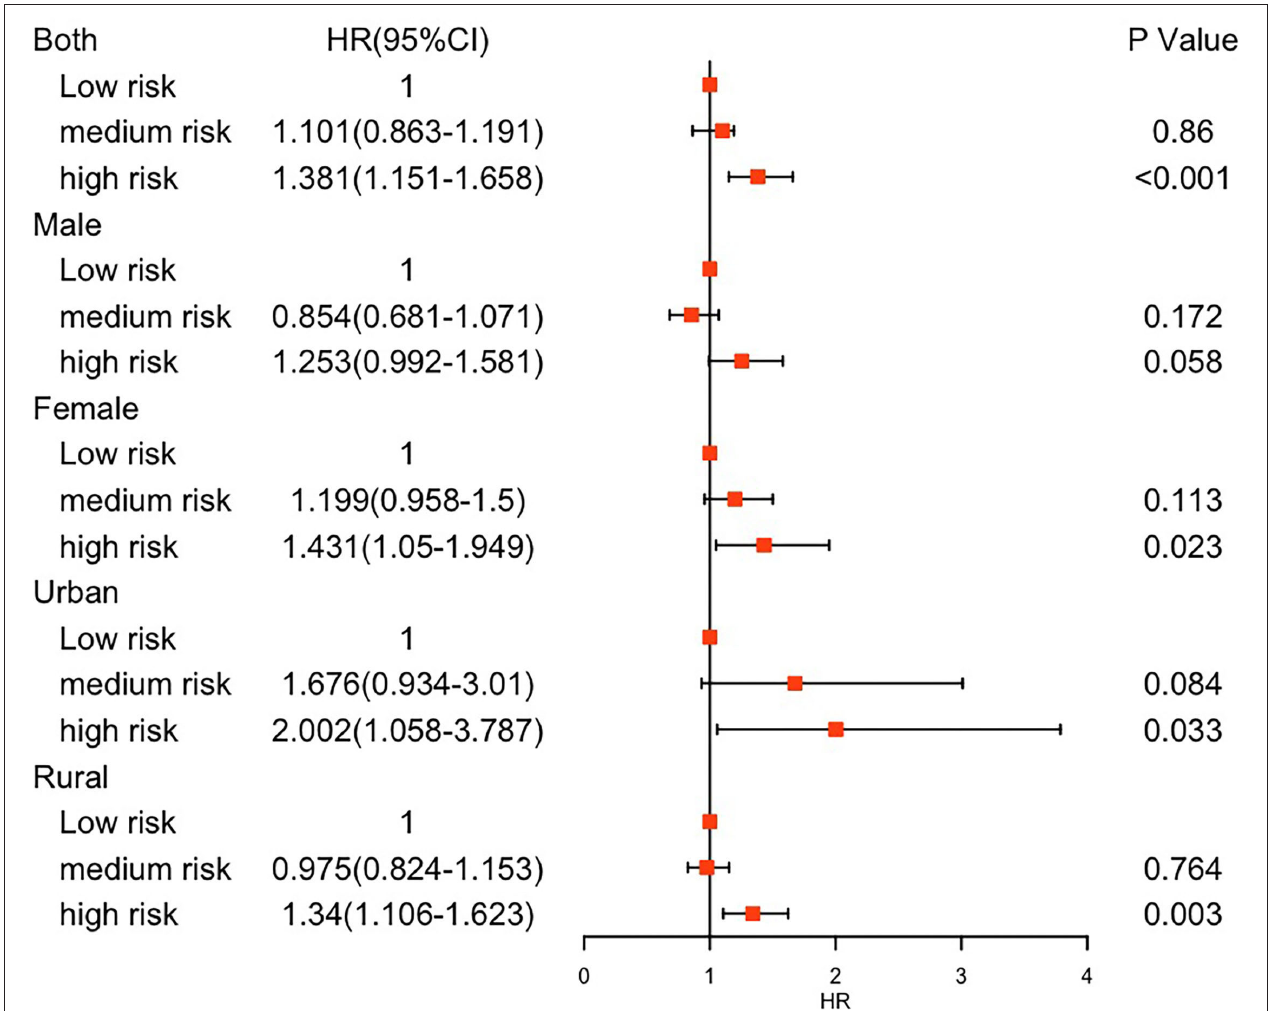
FIGURE 2 | Hazard risks of multimorbidity by living risk group. HR, hazard risk; CI, confidence interval.